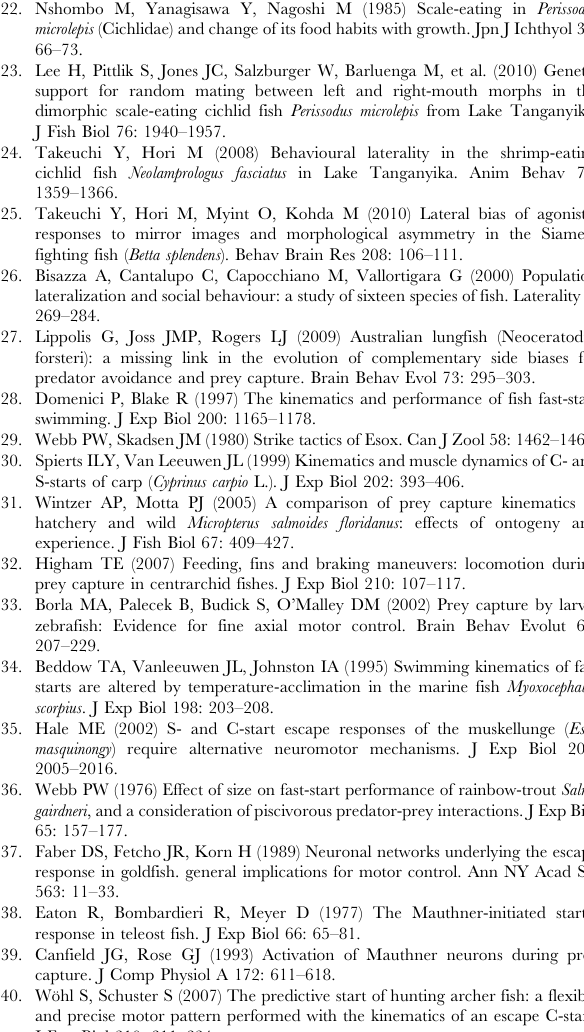
Figure S1 Mouth asymmetry of Perissodus microlepis . (A) Dorsal views of the mouth morphologies of lefty and righty fish. Yellow lines indicate the lateral tips of the lips. In the lefty fish, this line clearly leans to the right and vice versa. (B) The left and right